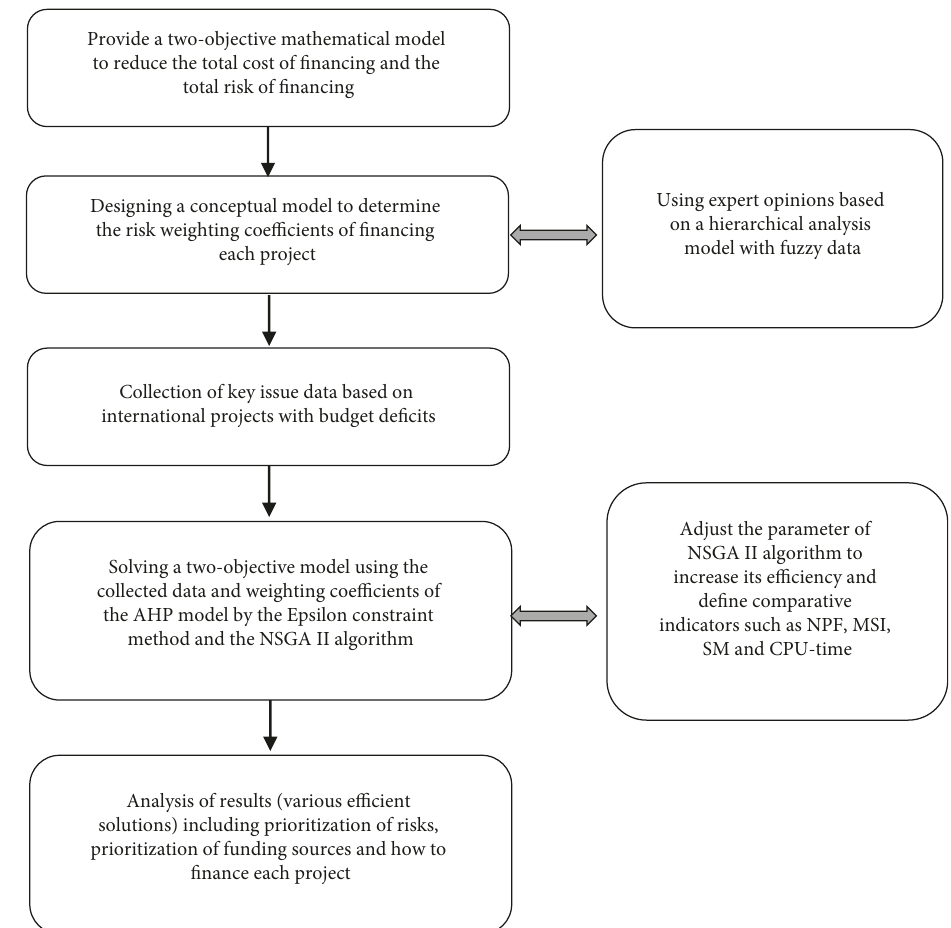
Figure 2: Flowchart of how to achieve the financing of sustainable